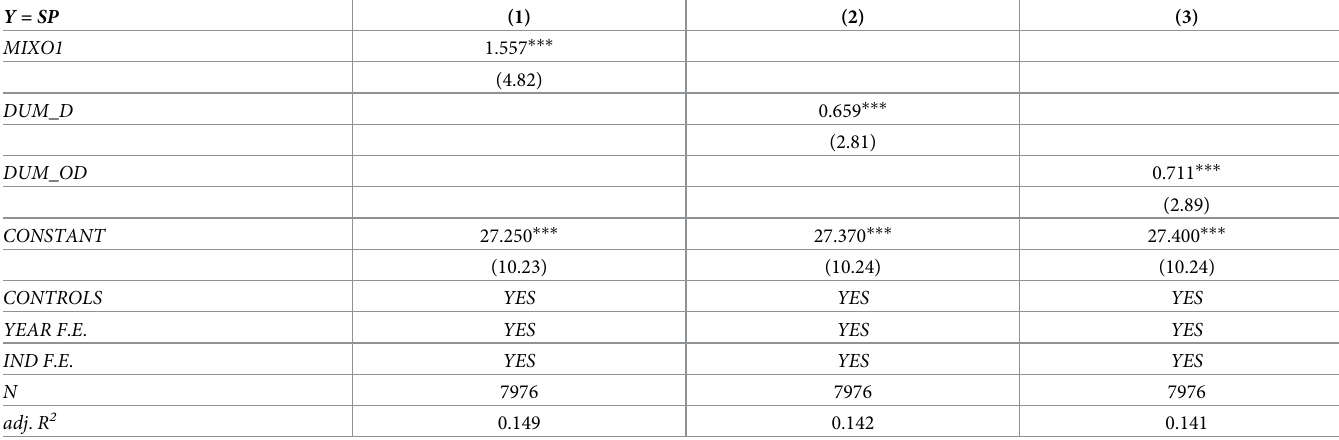
Table 8. Alternative measures of explanatory